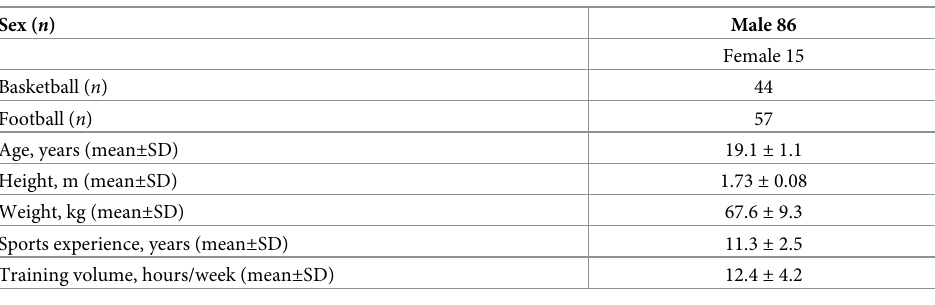
Table 1. Participants’